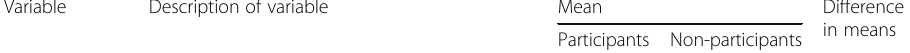
in means Participants Non-participants